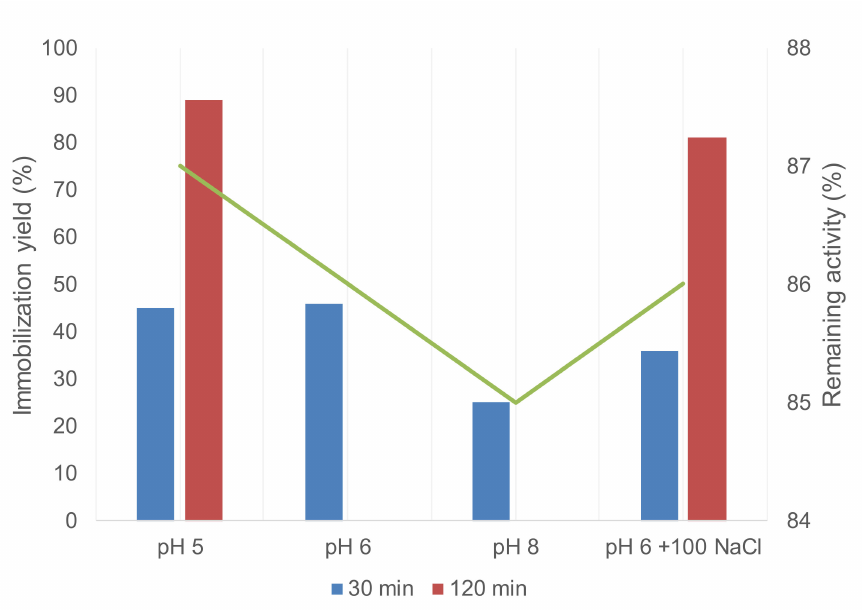
Figure 5. Immobilization of GTLC193_SeH on geranyl-SP support at different conditions. Remaining activity